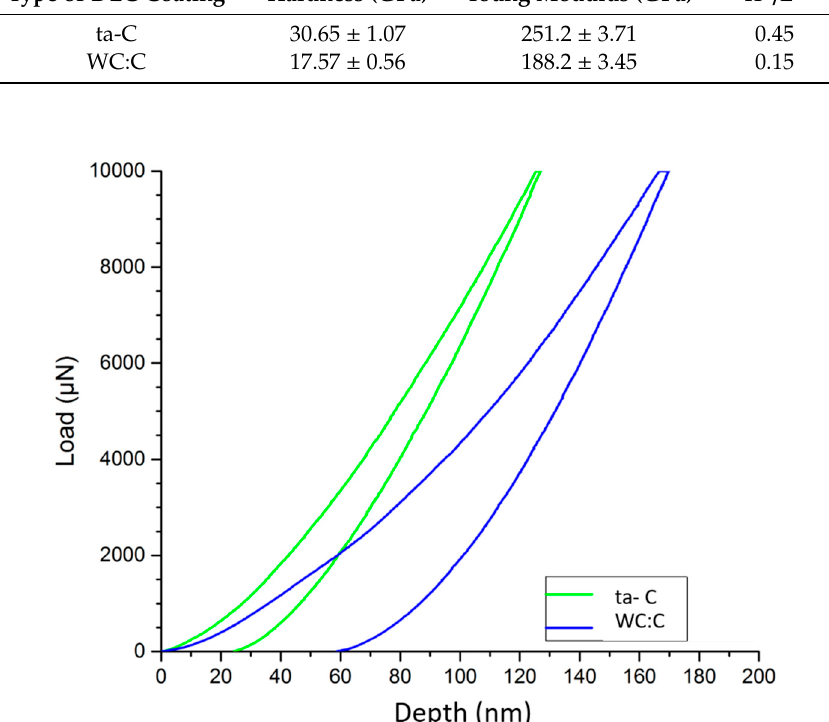
Figure 6. Nanoindentation curves for a specific final load of 10 mN in the ta-C coating (green plot) and WC:C coating (blue plot).